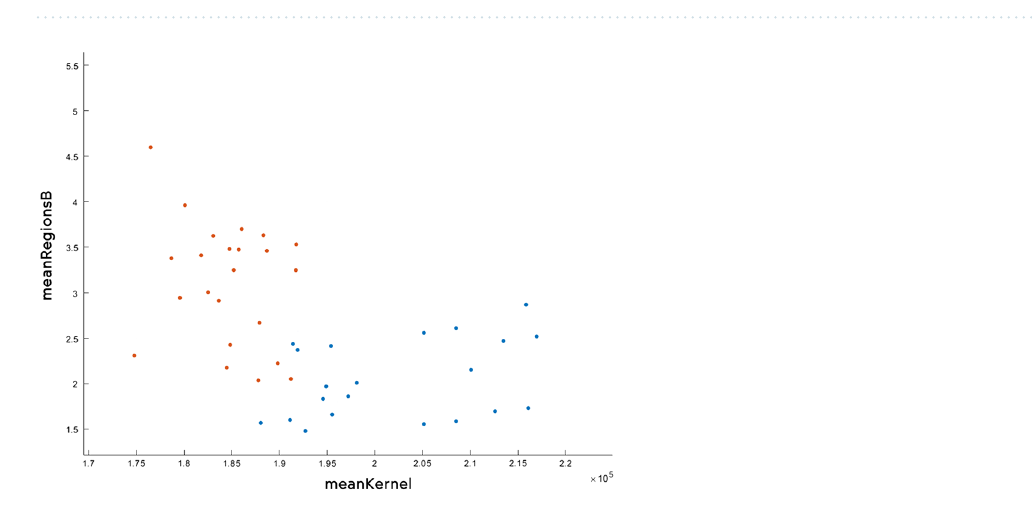
Figure 24. Confusion matrixes: (1) fine KNN; (2) weighted KNN; (3) linear SVM.